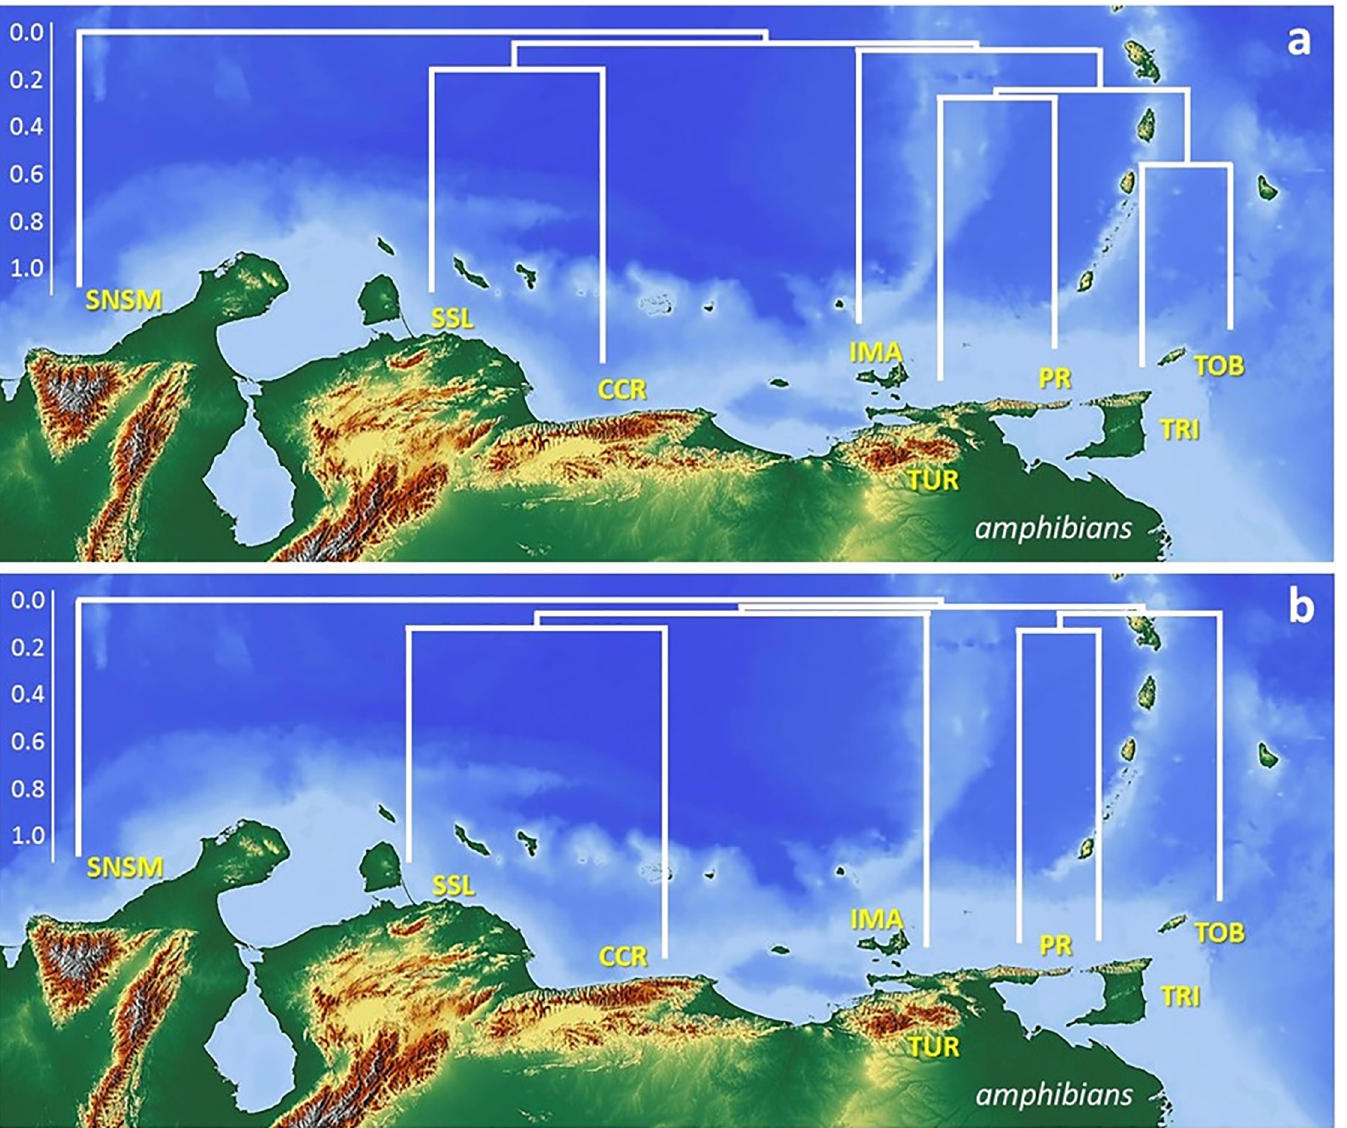
Fig 4. Distribution patterns of amphibians in the different orographic regions. Cluster classification for amphibians (a) found above 200 m in elevation and (b) found exclusively at mid altitude mountain vegetation, based on the UPGMA algorithm and the Jaccard coefficient (cophenetic correlation r = 0.95 and r = 0.92). SNSM (Sierra Nevada de Santa Marta, Colombia), SSL (Sierra de San Luis), CCR (Central Coastal Range), IMA (Isla de Margarita), TUR (Turimiquire Massif), PR (Paria Range), TRI (island of Trinidad), TOB (island of Tobago). Map build with GIS Cloud Apps (www.giscloud.com). Reprinted from Relief Free Map under a CC BY license, with permission from the Open Data Commons Open Database License (ODbL) by the OpenStreetMap Foundation (OSMF), original copyright OpenStreetMap 1 . https://doi.org/10.1371/journal.pone.0246829.g004 S3 Text): Mannophryne venezuelensis , Rhinella marina , Flectonotus fitzgeraldi , Pristimantis